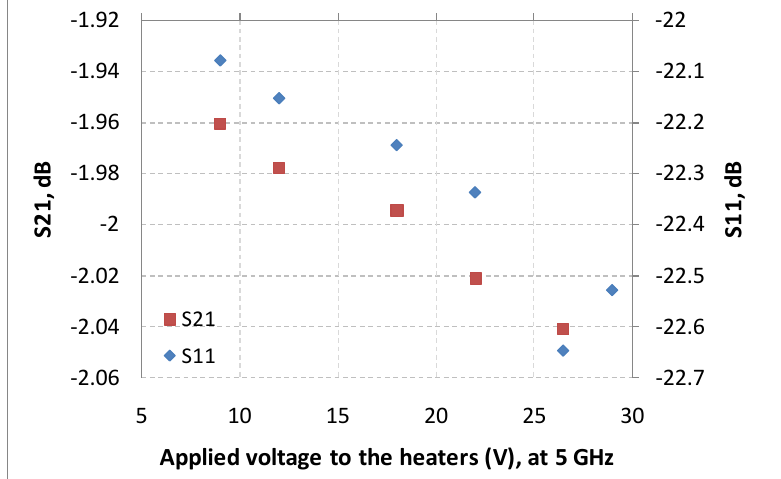
Figure 8. scattering parameters vs. applied voltage to the heaters, f = 5 GHz.